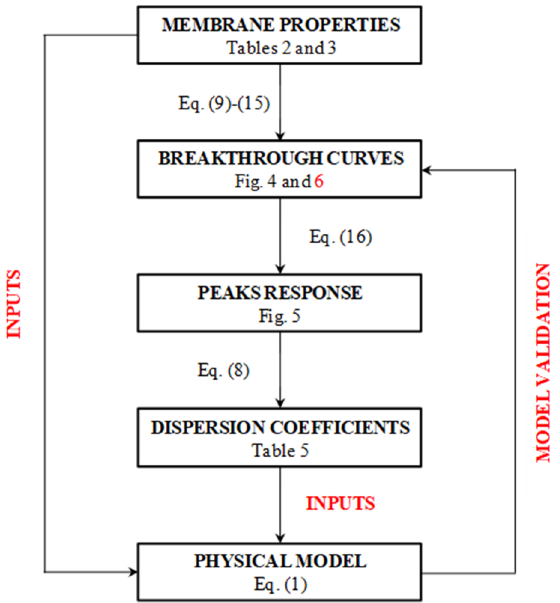
Figure 3. Block diagram of the logical path used to validate the model with references to equations and tables in the text.